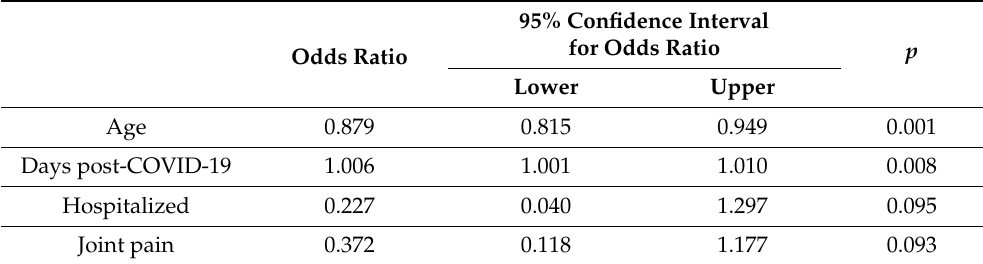
Table 2. Logistic regression to predict achievement of 85% maximum predicted HR during exercise. 95% Confidence Interval for Odds Ratio p Odds Ratio Lower Upper Age 0.879 0.815 0.949 0.001 Days post-COVID-19 1.006 1.001 1.010 0.008 Hospitalized 0.227 0.040 1.297 0.095 Joint pain 0.372 0.118 1.177